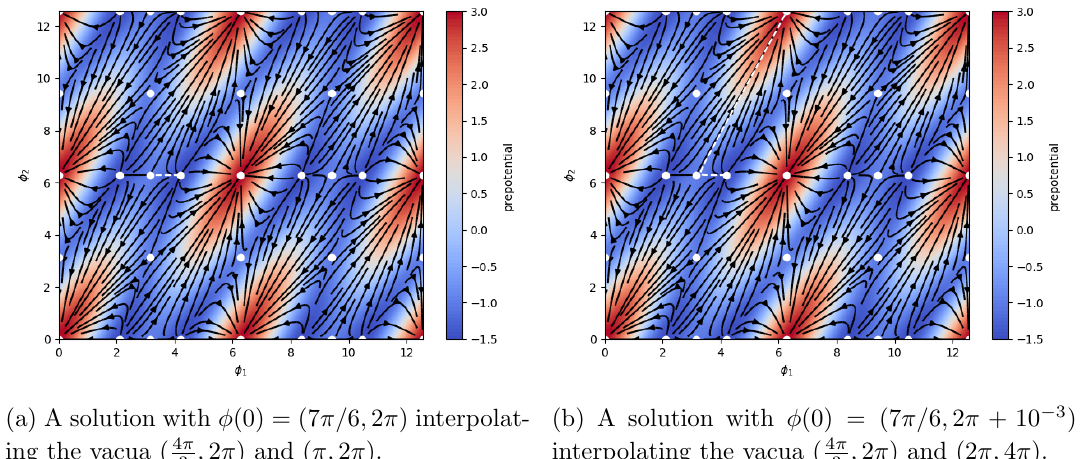
(b) A solution with (cid:30) (0) = (7 (cid:25)= 6 ; 2 (cid:25) + 10 (cid:0) 3 ) interpolating the vacua ( 4 (cid:25) ; 2 (cid:25) ) and (2 (cid:25); 4 (cid:25) ). 3